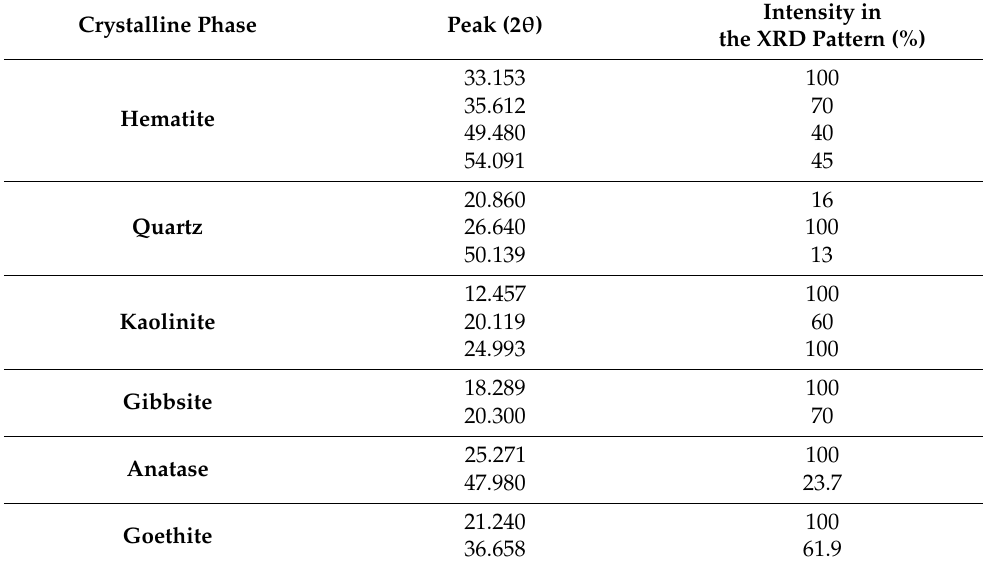
Table 1. Some crystalline mineral phase peaks and the intensity in which they appear in the XRD patterns. Data obtained from HighScore Plus 3.0 library. There are more peaks that are not presented here because they have lower